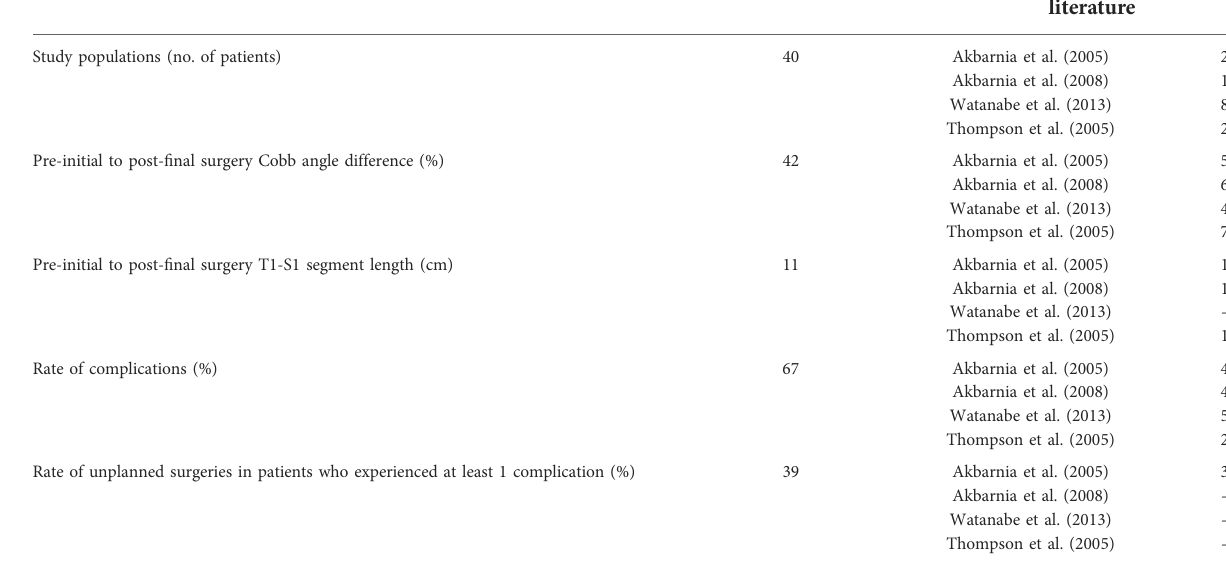
TABLE 2 Comparison between our results and data available in the literature. Study populations and